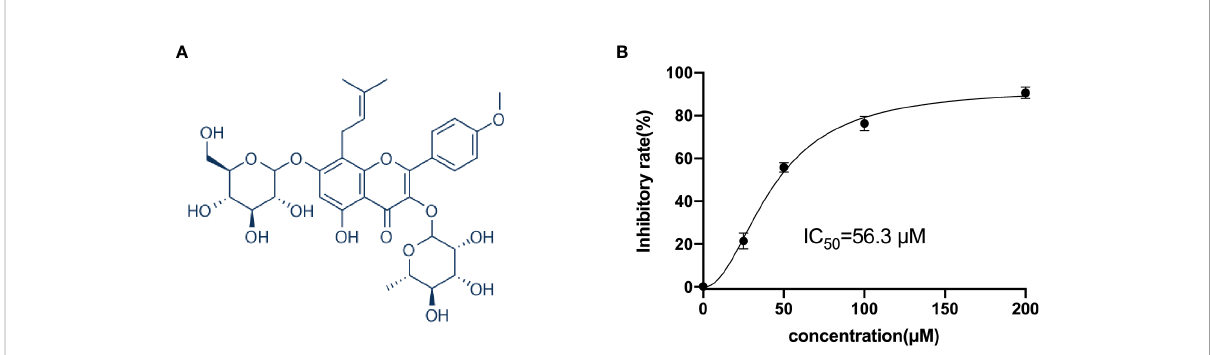
FIGURE 1 Icariin suppressed the proliferation of SKOV-3 cells. (A) The molecular structure of icariin. (B) The cells grew overnight in a 96-well plate, icariin at indicated concentrations (25, 50, 100, and 200 m M) was used to treat SKOV-3 cells for 72 h. Cell viability was assessed with the CCK8 assay. The calculated IC 50 value was 56.3 µM. All graphs were generated with GraphPad Prism v.9.0.0. Data were shown as mean±SD